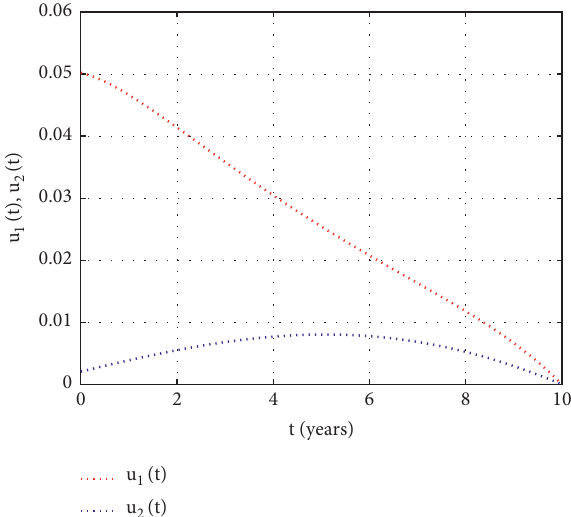
Figure 8: Simulation of preventive and treatment